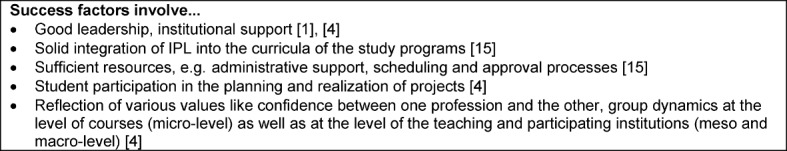
Success factors for implementing IPE